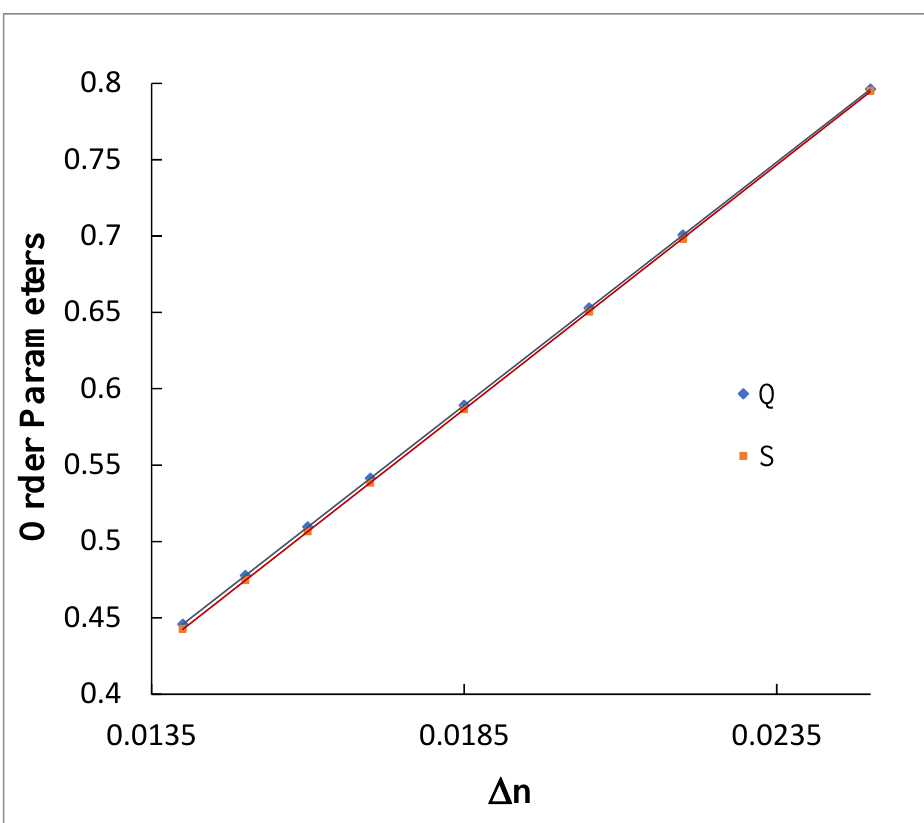
Figure 10. The variability of the microscopic parameters (Q and S ) with birefringence (∆ n ).